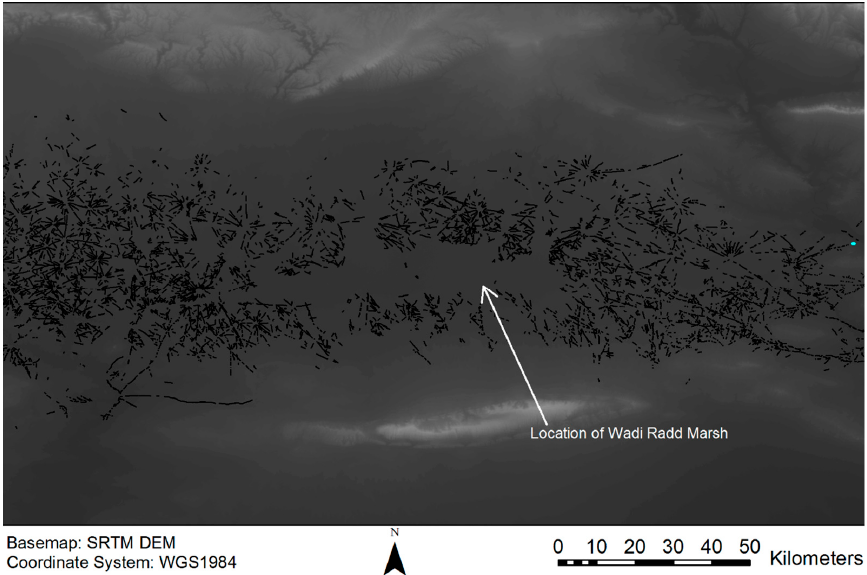
Figure 19. Contrary to the hollow ways in Southern Mesopotamia, hollow ways found in Northern Mesopotamia do not occur in former marshland, in fact, the former Wadi Radd Marsh is easily identified by a conspicuous gap in the hollow ways of the North Jazira